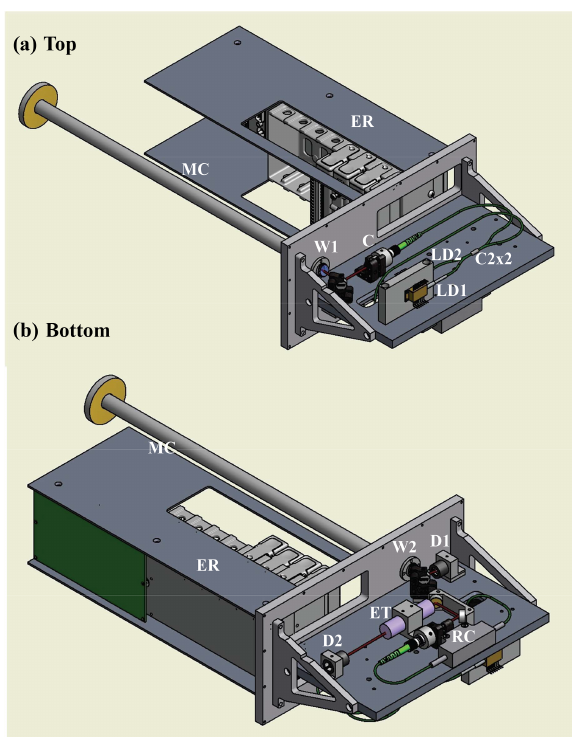
Figure 2. Set-up of the analyser. (a) Top view. LD1 and LD2 diode lasers, C2 × 2: fibre coupler 2 × 2 50/50 transmission; C: colli- mator, W1: CaF 2 window for the entrance of the multipass cell MC. (b) Bottom view. RC: reference cell, ET: BK7 etalon, W2: CaF 2 window for the output of the multipass cell MC, D1 and D2 detectors. ER: rack for